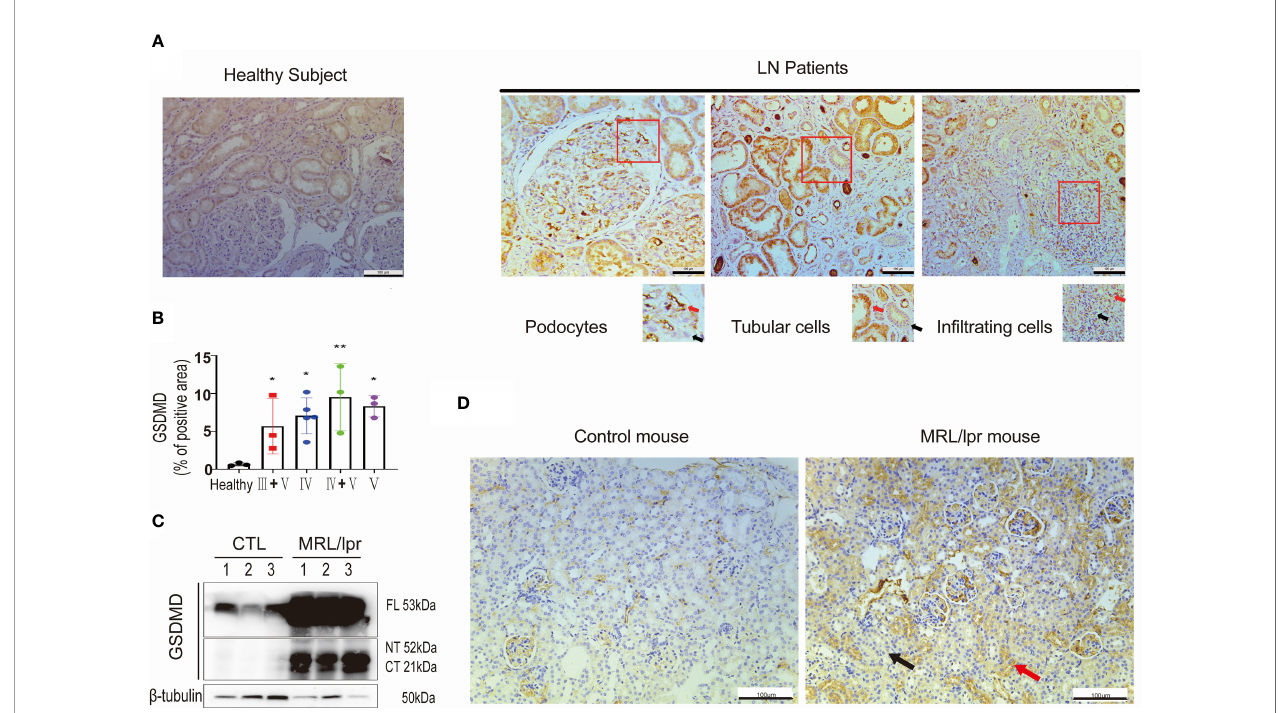
FIGURE 1 | GSDMD is strongly elevated and cleaved in the kidneys of patients and mice affected by LN. (A) Immunochemical staining of GSDMD in renal specimens taken from healthy subjects and LN patients, positive (Red arrows) and negative staining (Black arrows) were enlarged. (B) Quanti fi cation of GSDMD- positive areas is shown in type III+V, IV, IV+V, V LN patients and heathy subjects. (C) Immunoblot analysis of full-length, cleaved N-terminal domain and C-terminal domain GSDMD in renal cortex from three pairs of control and MRL/lpr mice. (D) Immunochemical staining of GSDMD in kidney specimens taken from controls and MRL/lpr mice. * p < 0.05, ** p < 0.01. LN, lupus nephritis; FL, full-length; NT, N-terminal domain; CT, C-terminal